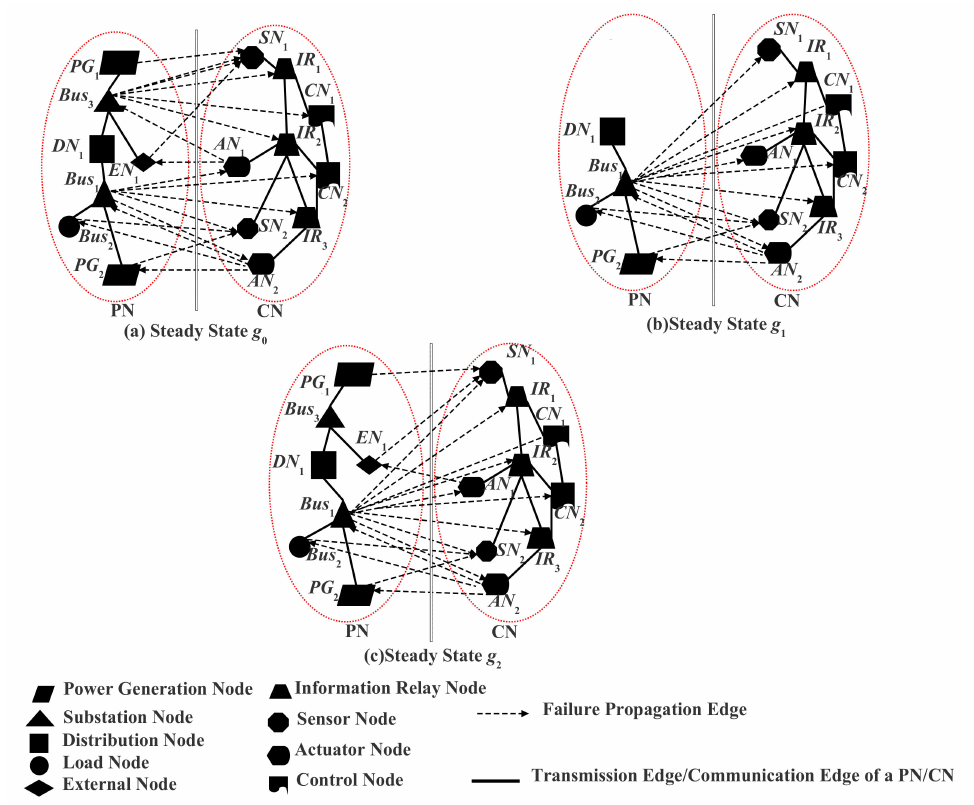
Figure 2. State transitions of an ADN during the propagation of